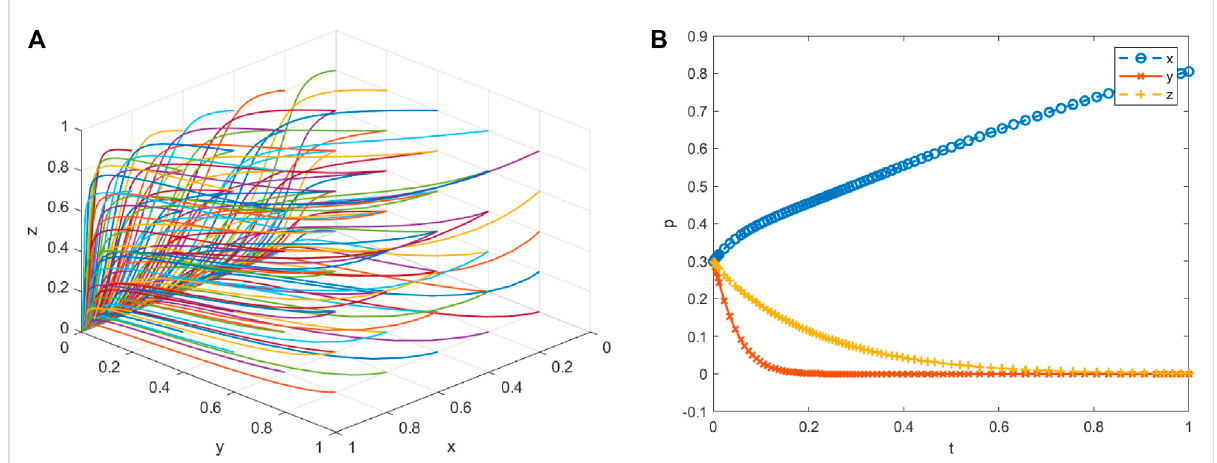
FIGURE 5 Simulation results of Scenario 4 evolution. (A) The three-dimensional phase diagram, which can show the evolution situation more clearly, and (B) The two-dimensional diagram, which can show the sensitivity of the game subject to the income more